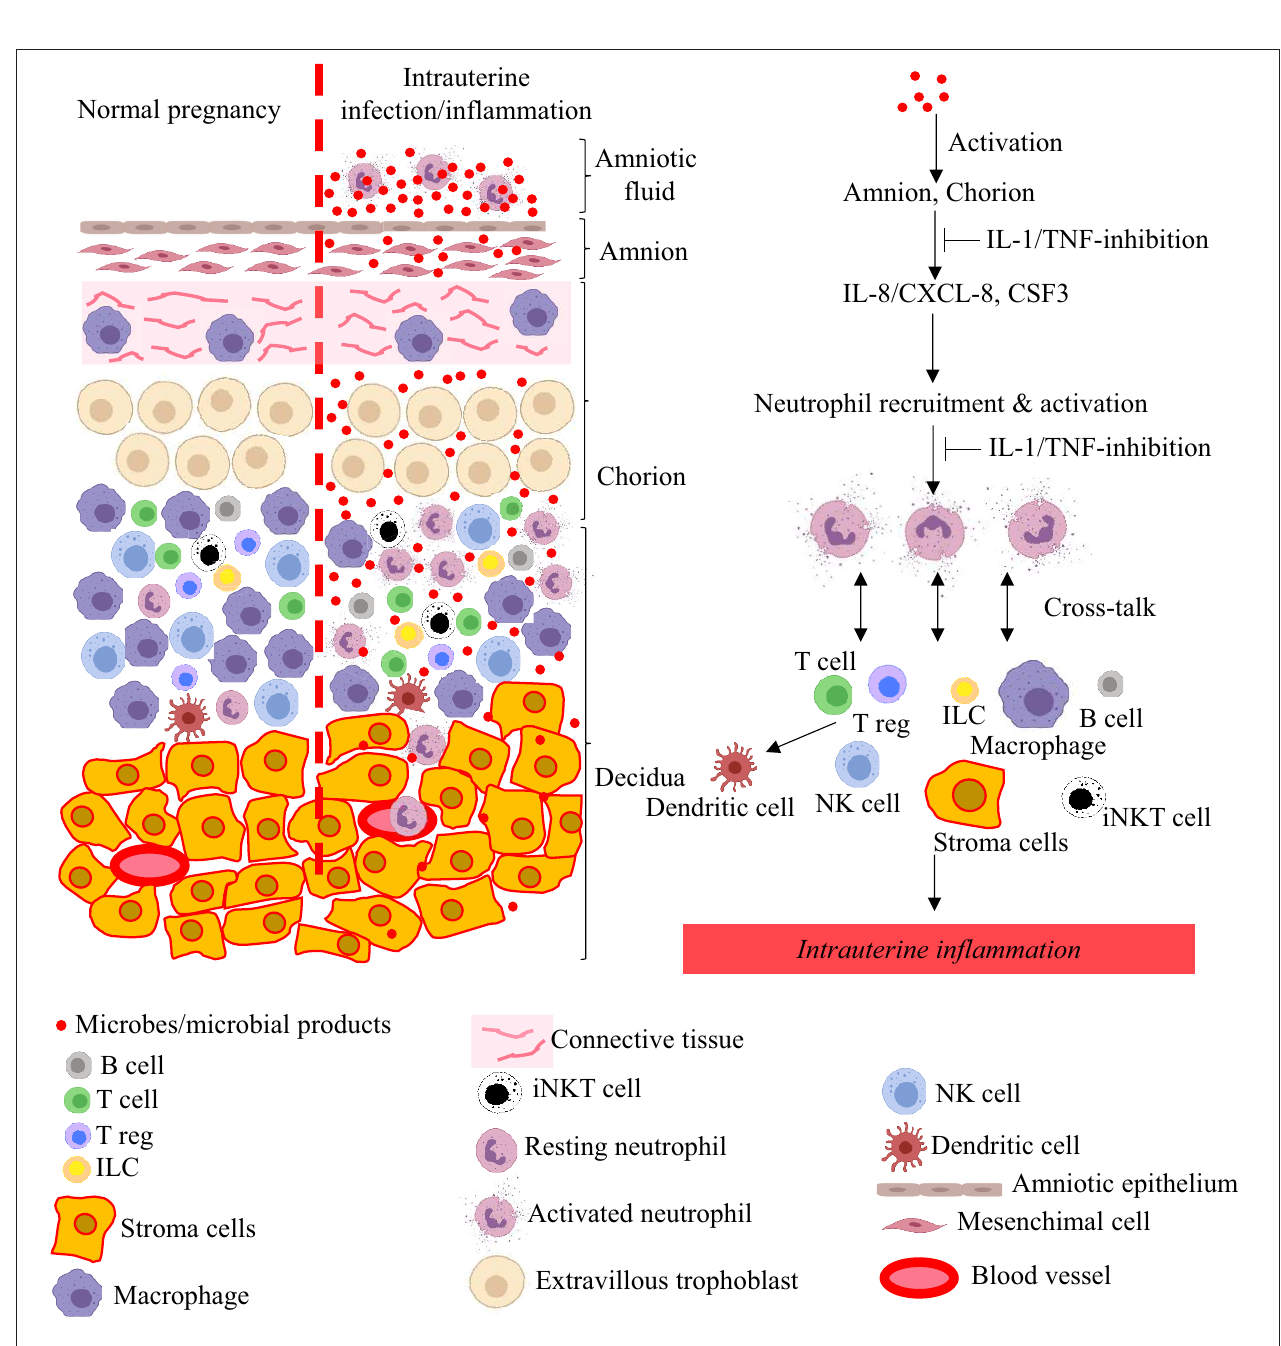
FIGURE 3 | Model for pathogenesis of intrauterine infection/inflammation. Representative cells in the different tissue layers of fetal membrane are shown. The left panel in figure depicts normal pregnancy and the right panel shows changes during IUI. Inflammatory products and microbial products (red dots) in the amniotic fluid and choriodecidua activate the amnion and chorion, resulting in the release of neutrophil chemoattractant (CXCL-8/IL-8 and CSF3) in a IL-1 and TNF-dependent manner. Neutrophils accumulate at choriodecidua junction, get activated, and greatly amplify the inflammation at the maternal-fetal interface with cross-talk with other immune and resident